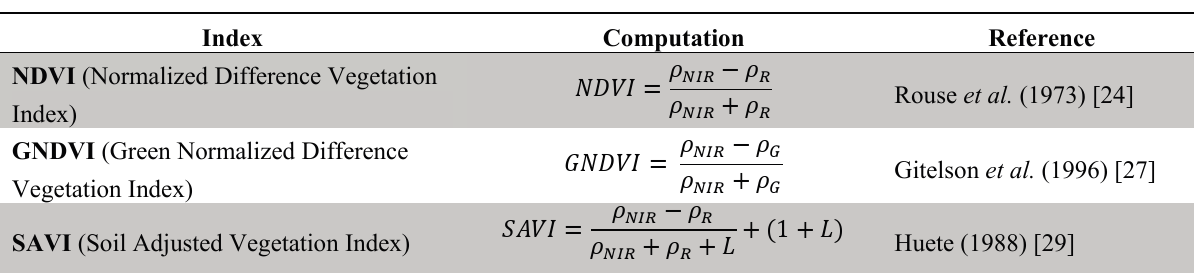
Table 2. The considered vegetation indices. ρ the specific bands; L is a constant empirical value related to the vegetation density on the